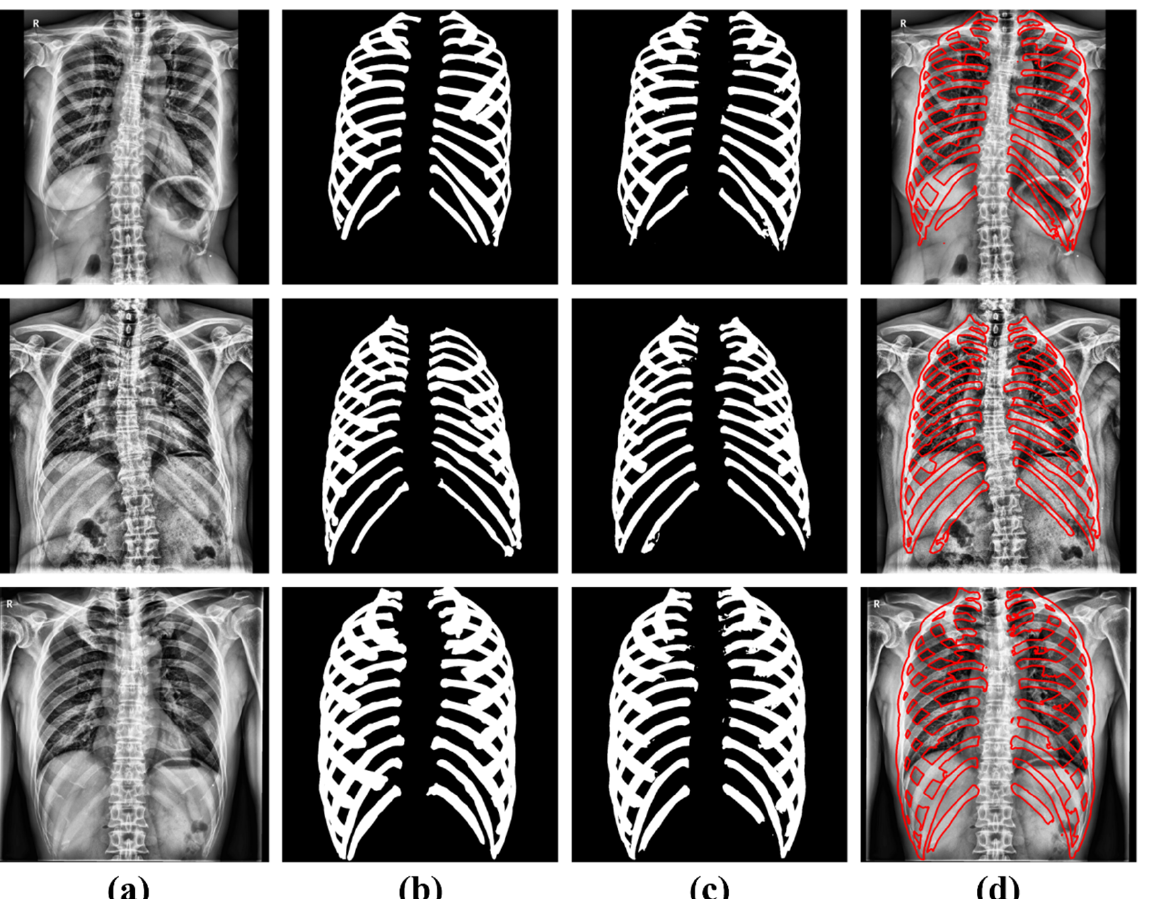
Figure 4. Segmentation model results. ( a ) Original images, ( b ) Ground truth images, ( c ) U-Net predicted images, and ( d ) Overlay images with ( a , c ).